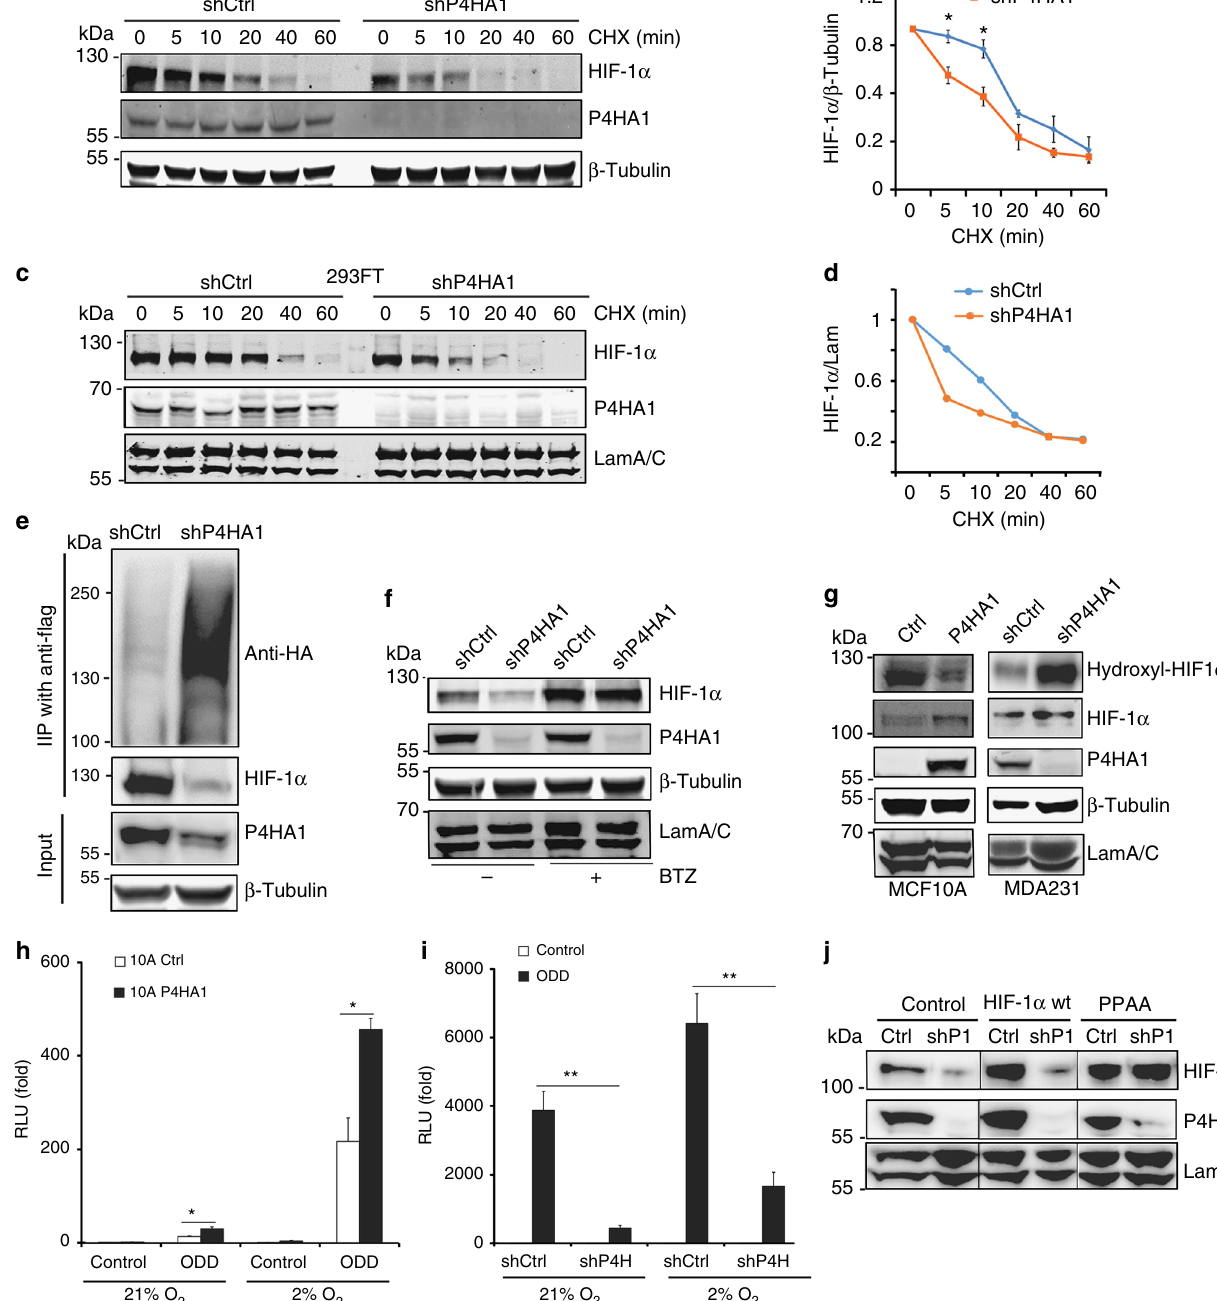
Fig. 3 P4HA1 enhances HIF-1 α protein stability. a , b Analysis of HIF-1 α protein degradation in control and shP4HA1-expressing MDA-MB-231 cells with cycloheximide (CHX, 100 μ M) treatment (0, 5, 10, 20, 40, and 60 min). Results are presented as mean ± SEM. n = 3; * p < 0.05, independent Student ’ s t test. c , d Analysis of HIF-1 α protein degradation in control and shP4HA1-transfected 293FT cells with cycloheximide (CHX, 100 μ M) treatment (0, 5, 10, 20, 40, and 60 min). e Immunoprecipitation and western blot analysis of HIF-1 α ubiquitination in 293FT cells transfected with HIF-1 α -Flag and UB-HA construct, plus shCtrl or shP4HA1 plasmids. f Western blot assessing HIF-1 α protein levels in control and P4HA1-silenced MDA-MB-231 cells treated with proteasome inhibitor Bortezomib (BTZ) for 12 h. g Analysis of hydroxylated HIF-1 α (P402) levels in control and P4HA1-silenced MDA-MB-231 cells, control or P4HA1-expressing MCF10A cells. h , i ODD-luciferase reporter activity in control, P4HA1-expressing MCF10A cells, and P4HA1-silenced MDA- MB-231 cells under normoxia and hypoxia conditions. Results are presented as mean ± SEM; n = 3; ** p < 0.01, * p < 0.05, one-way ANOVA test. j HIF-1 α protein levels were assessed in control and P4HA1-silenced MDA-MB-231 cells with wild-type HIF-1 α or proline hydroxylation-de fi cient HIF-1 α PPAA